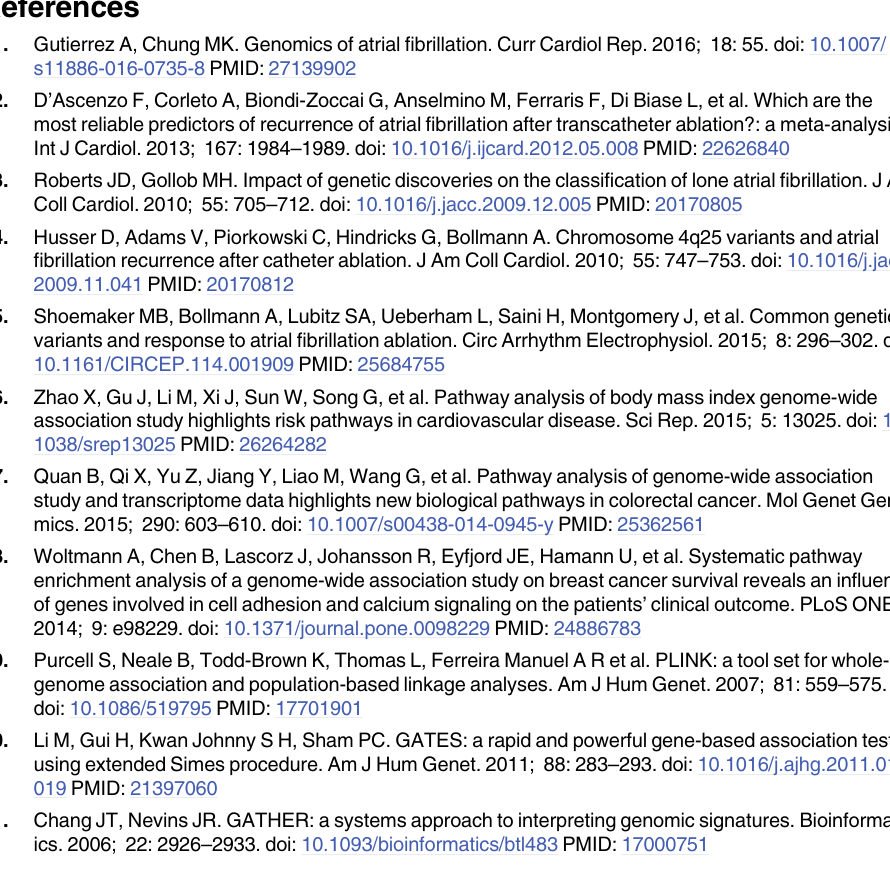
S1 Table. KEGG pathways associated with LAD using WebGestalt (in alphabetical order). S2 Table. KEGG pathways associated with AF type using WebGestalt (in alphabetical